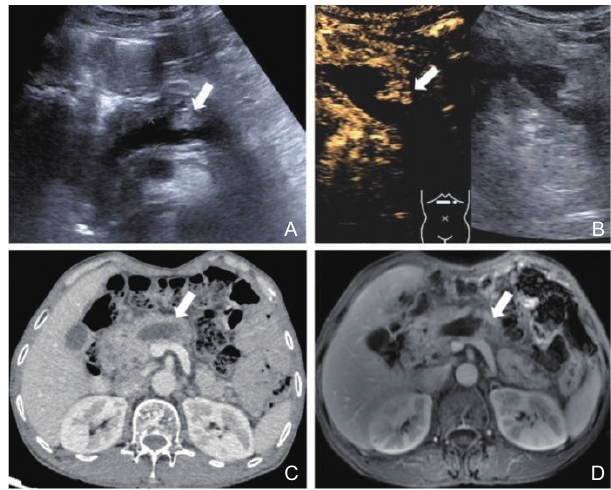
Figure 1 A 64-year-old male patient with pancreatic IPMN and an associated invasive carcinoma. Transabdominal ultrasound displayed a hyperechoic mural nodule in the dilated pancreatic duct (A) and contrast- enhanced ultrasonography showed an obvious enhancement of the mural nodule (B). Computed tomography (C) and magnetic resonance imaging (D) showed the dilated pancreatic